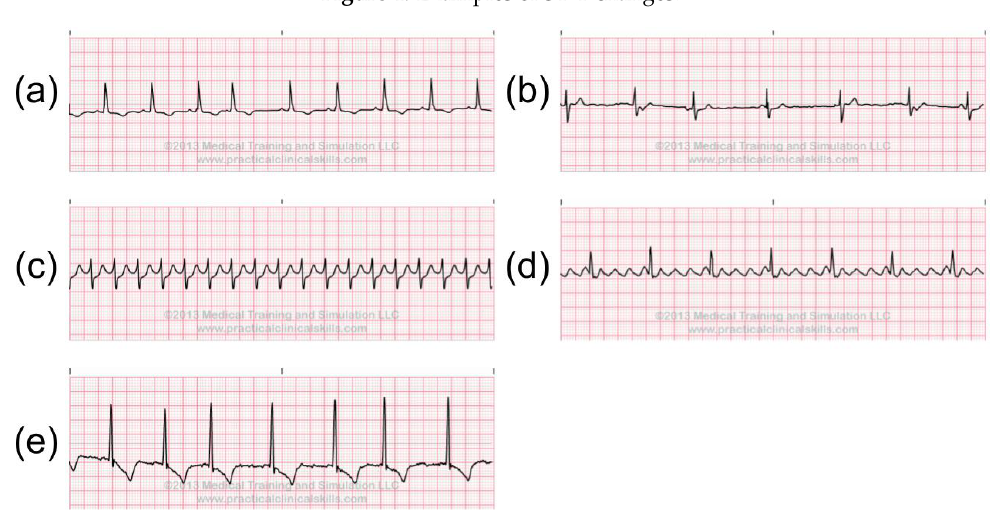
Figure 5. Abnormal Atrial Rhythms: ( a ) Premature Atrial Contraction, ( b ) Wandering Atrial Pacemaker, ( c ) Atrial Tachycardia, ( d ) Atrial Flutter, ( e ) Atrial Fibrillation [21]. Junctional Rhythms are another kind of ectopic rhythm. These occur when the atrioventricular (AV) junction paces the heart. In such a case, the P wave on the ECG signal may disappear or become negative. There are several anomaly examples shown in Figure 6: Premature Junctional Complex, Junctional Escape Rhythm, Junctional Tachycardia. The Premature Junctional Complex usually has the same cause as the Premature Atrial Contraction described previously. A Junctional Escape Rhythm could be caused by sick sinus syndrome, digitalis toxicity, excessive effects of beta-blockers or calcium channel blockers, acute myocardial infarction, hypoxemia, and hyperkalemia. One of the most